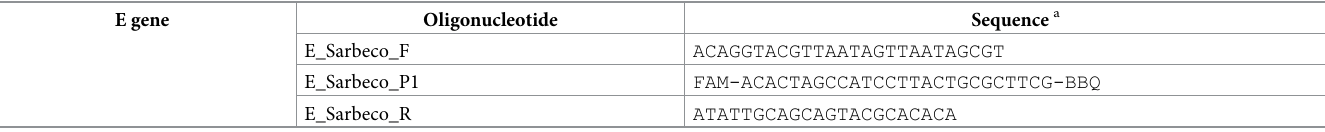
Table 1. E Gene primers and probes for 2019 SARS-CoV2 real time- RT-PCR. E gene